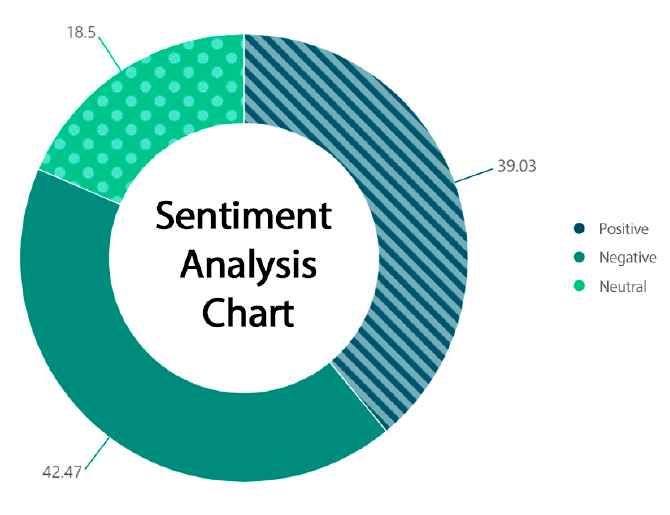
Figure 9. Sentiment analysis chart (during the outbreak).